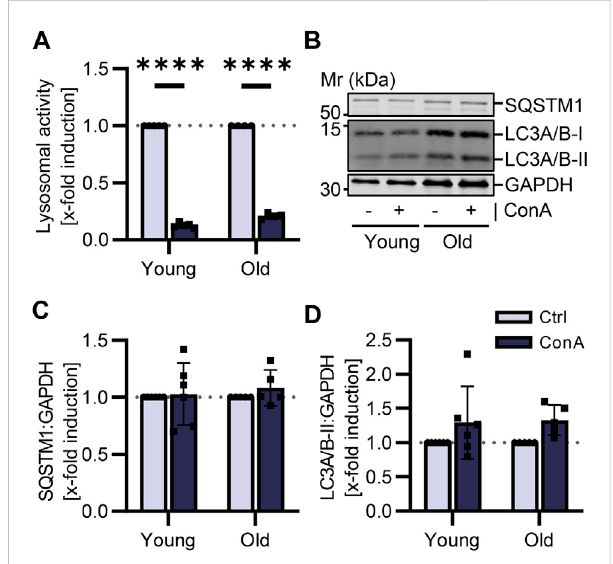
FIGURE 4 Autophagic fl ux was not affected by aging in murine cardiomyocytes.Cardiomyocyteswereisolatedfromyoung(21-22 w) and old (105-106 w) mice and treated for 2 h at 37 ° C with 100 nM ConA. (A) Lysosomal activity of murine cardiomyocytes was decreased by ConA in both age groups ( n = 4 – 5). (B) Representative western blot for SQSTM1, LC3A/B-I, LC3A/B-II and GAPDH in control and ConA treated cardiomyocytes from young and old mice. (C) In young and old cardiomyocytes, SQSTM1 and (D) LC3A/B-II both normalized to GAPDH were not changed by ConA treatment (n = 5 – 6). Data represent mean ± SD. Statistical signi fi cance was